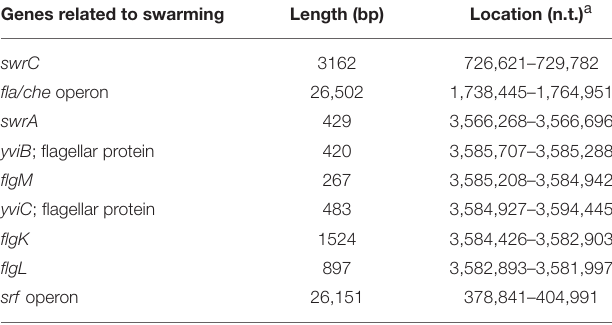
TABLE 1 | Genes in F29-3 related to swarming.